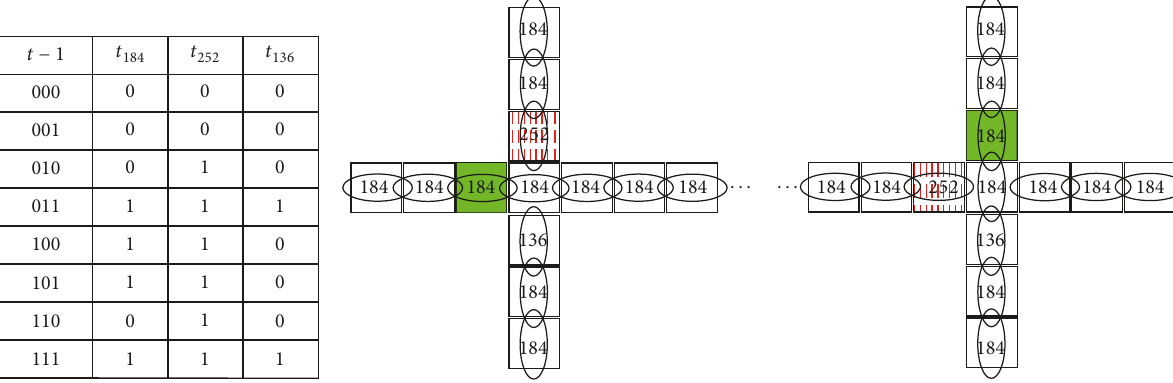
of its two closest neighbors. Each cell can take only values of 0 or 1. We can assume that one cell represents five meters, roughly the space occupied by a stationary